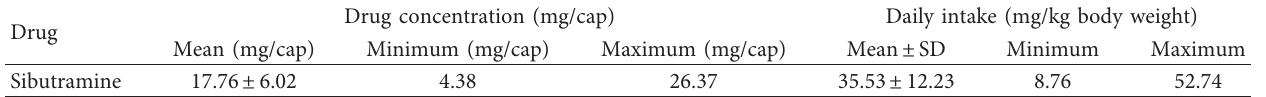
Table 3: The sibutramine level and its daily intake through consumption of herbal medicine. Drug concentration (mg/cap) Drug